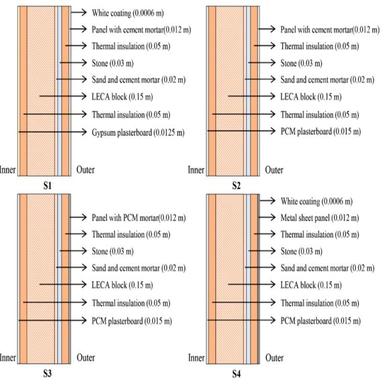
Proposed wall options for the existing south-facing facade with stone.